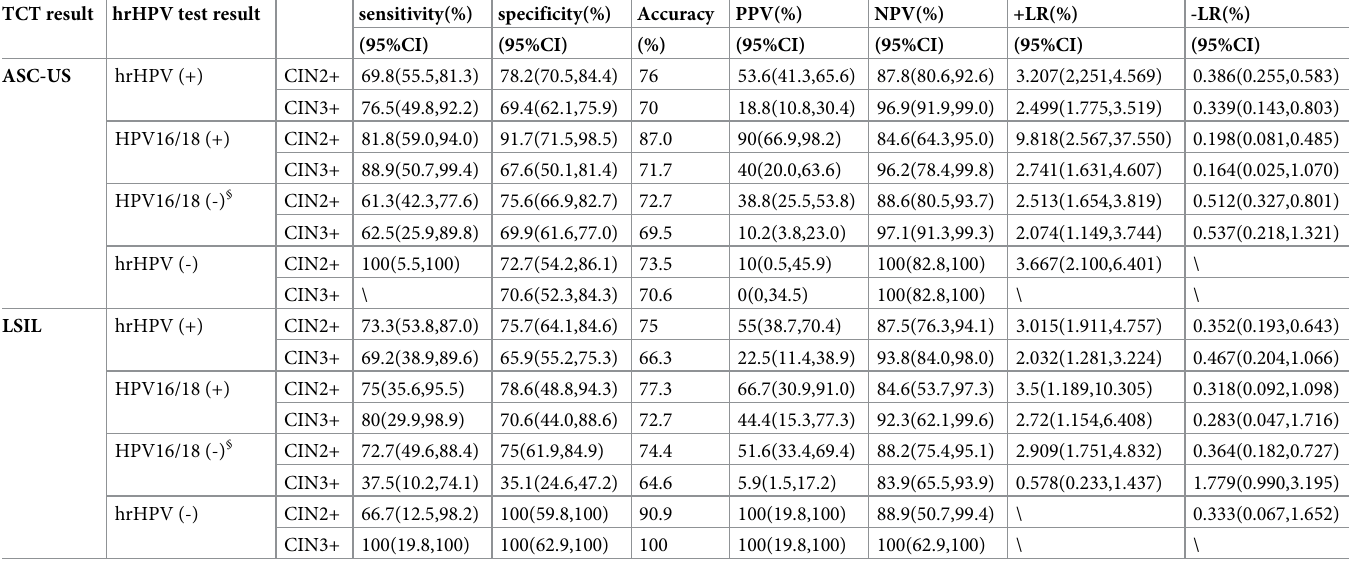
Table 4. The performance of OCT for detecting CIN2+/CIN3+ combined with hrHPV